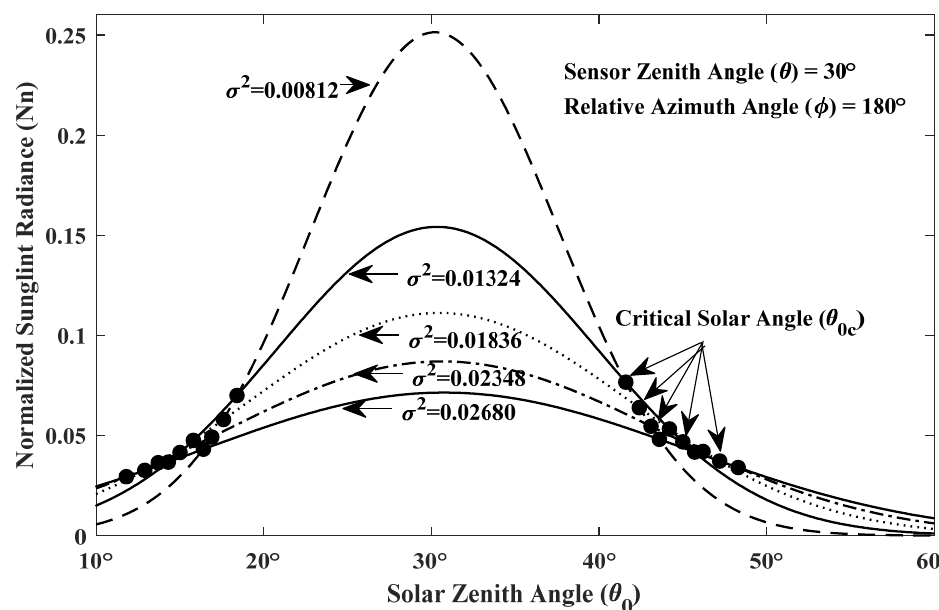
Figure 4. Schematic diagram showing the critical solar viewing angle ( θ 0c ). The sensor zenith angle ( θ ) is 30 ◦ , and the relative azimuth angle ( φ ) is 180 ◦ , which remain fixed. The sea surface roughness variance ( σ 2 ) corresponding to the curves is 0.00812, 0.01324, 0.001836, 0.02348 and 0.02680.